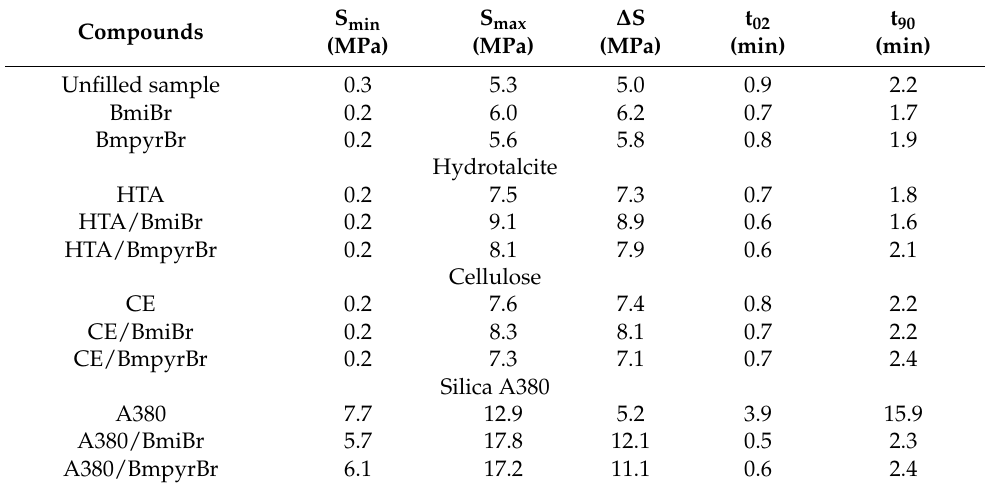
Table 5. Cure characteristics at 160 ◦ C of NR compounds (S min , minimum torque; S max , maximum torque; ∆ S, torque increase; t 02 , scorch time; t 90 , optimal vulcanization time; standard